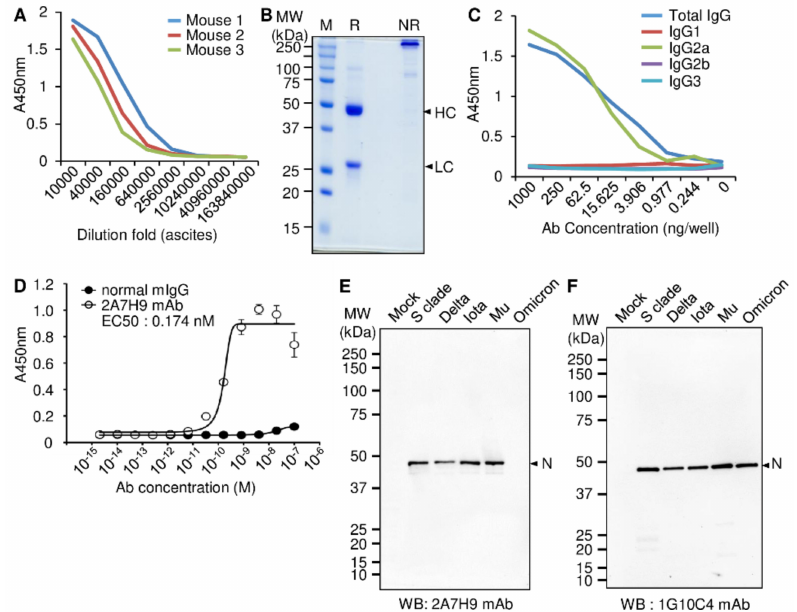
Figure 1. Production and characterization of a mouse mAb against the SARS-CoV-2 N protein. ( A ) Hybridoma cells (2A7H9 clone) were injected into the peritoneal cavity of BALB/c mice ( n = 3), and ascetic fluid was collected. To estimate the production of SARS-CoV-2 N protein-specific mAbs (2A7H9 mAb) in ascites, an ELISA was performed using a 96-well immuno plate coated with recombinant SARS-CoV-2 N-Bio-His 6 protein, and a titration curve was obtained. ( B ) The 2A7H9 mAb was purified by Protein A column chromatography and then analyzed by SDS-PAGE in reducing (R) or non-reducing (NR) conditions. HC, heavy chain; LC, light chain. ( C ) The IgG subclass of the purified 2A7H9 mAb was analyzed by an ELISA. ( D ) The binding affinity of the 2A7H9 mAb to recombinant SARS-CoV-2 N protein was determined by an ELISA. ( E , F ) Lysates of SARS-CoV-2 S clade, delta, iota, mu, and omicron variants (1 × 10 4 pfu/well) were separated on a 4–12% Bis-Tris gradient gel. Western blotting was performed with the 2A7H9 mAb ( E ) or 1G10C4 mAb ( F ) to analyze the binding ability of the antibodies to N proteins of SARS-CoV-2 S clade, delta, iota, mu, and omicron variants. N, SARS-CoV-2 N